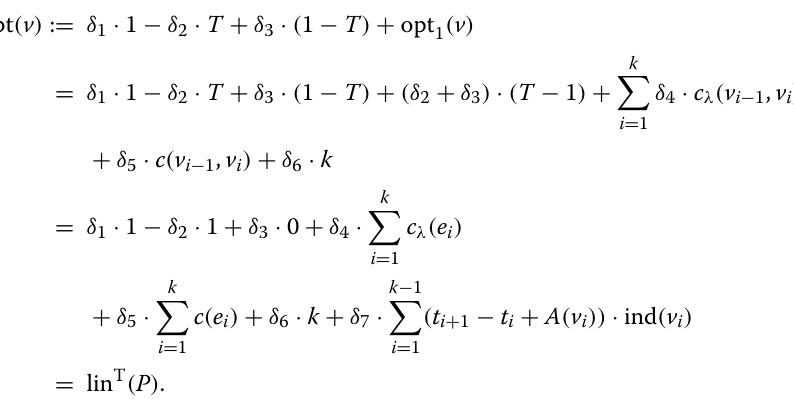
( v ) , 1 ) to L ( v ) and 1